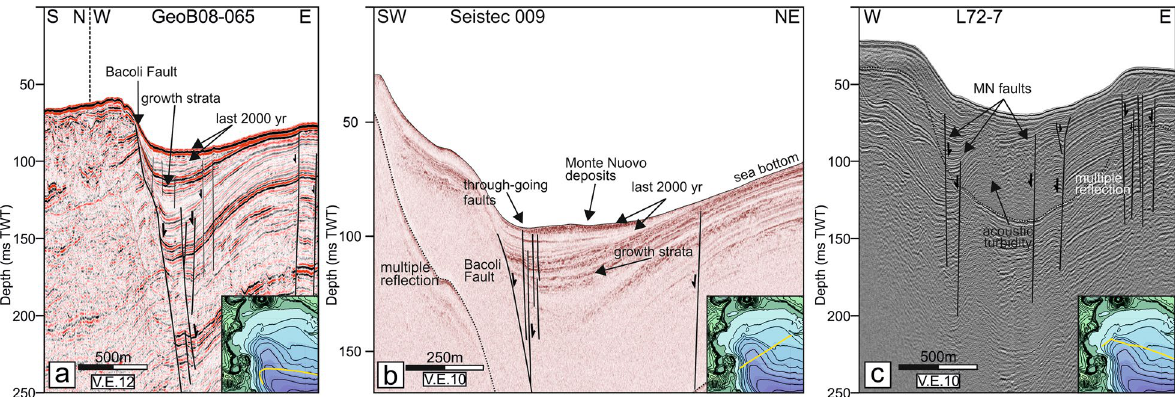
Fig. 3 a W–E-oriented seismic profile GeoB08-065, showing the Bacoli Fault and its synthetic faults accommodating the creep displacement along the western segment of the caldera inner-ring fault (modified after Natale et al. 2022a, b). b NE–SW-oriented high-resolution Seistec-009 shows the mainly plastic deformation of seismic units above the creeping Bacoli Fault and also cuts Monte Nuovo deposits (modified after Natale et al. 2020; 2022b). c WNW–ESE oriented seismic profile L72 shows the creeping Monte Nuovo Faults (modified after Aiello et al. 2012). VE vertical exaggeration. For locations, see the bottom-right